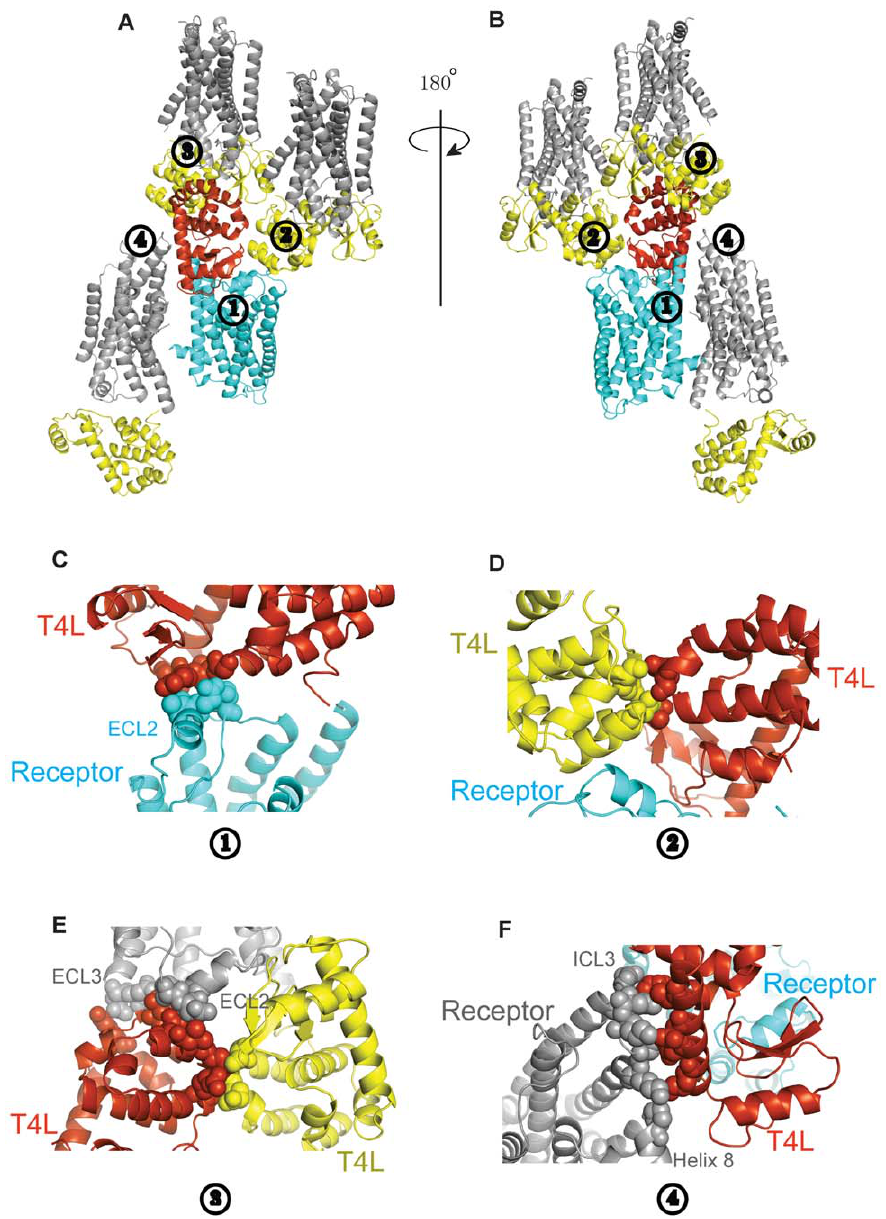
Figure 5. Packing interactions in the crystal structure. A, B. Packing interactions mediated by T4L. Each T4L packs against three adjacent T4L- b 2 AR- D ICL3 molecules and is involved in 4 packing interactions. The T4L and b 2 AR- D -ICL3 from the reference molecule are shown in orange and cyan, respectively. The T4L and b 2 AR- D -ICL3 from the three adjacent molecules are shown in yellow and dark grey, respectively. C–F. Close-up view of packing interactions 1–4. The residues involved in interactions are shown as spheres C. In interaction 1 the reference T4L packs against ECL2 of its fused b 2 AR- D -ICL3. D. In interaction 2 the reference T4L packs against T4L of an adjacent T4L- b 2 AR- D -ICL3. E. In interaction 3 the reference T4L packs against T4L, ECL2 and ECL3 of a second adjacent T4L- b 2 AR- D -ICL3. F. In interaction 4 the reference T4L packs against ICL3 and helix 8 of a third T4L- b 2 AR- D -ICL3. doi:10.1371/journal.pone.0046039.g005 Residues from Ser235 to Lys263 in the third intracellular loop VYDSLDAVRRAALINMVFQMGETGVAGFTNSLRMLQ- were deleted with the Quickchange multi protocol using synthetic QKRWDEAAVNLAKSRWYNQTPNRAKRVITTFRTGTW- oligonucleotides as mutation primers. All the constructs were DAYAADEVWVVGMGIVMSLIVLAIVFGNVLVITAIAKFE- confirmed by DNA sequencing. The protein sequence of T4L- RLQTVTNYFITSLACADLVMGLAVVPFGAAHILTKTWT- b D -ICL3 is shown below: FGNFWCEFWTSIDVLCVTASIETLCVIAVDRYFAITSPFK- 2 AR- YQSLLTKNKARVIILMVWIVSGLTSFLPIQMHWYRATH- MKTIIALSYIFCLVFA DYKDDDDAENLYFQ*GNIFEMLRI- QEAINCYAEETCCDFFTNQAYAIASSIVSFYVPLVIMVFV- DEGLRLKIYKDTEGYYTIGIGHLLTKSPSLNAAKSELDK- YSRVFQEAKRQLQKIDKFCLKEHKALKTLGIIMGTFTL- AIGRNTNGVITKDEAEKLFNQDVDAAVRGILRNAKLKP-